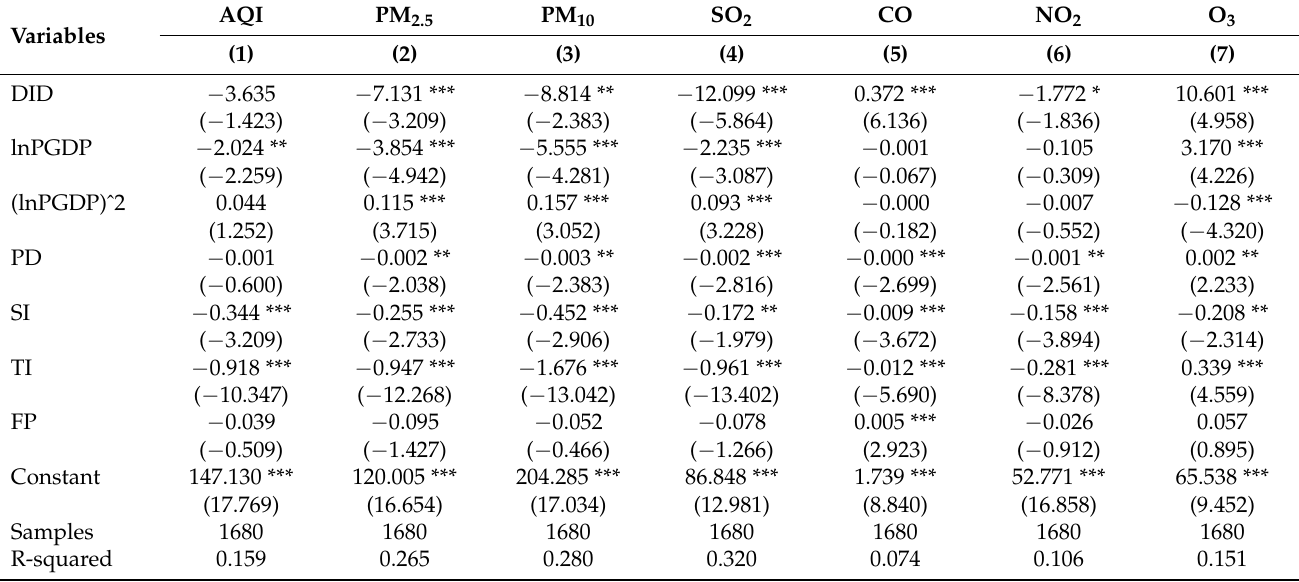
Table 2. The baseline results based on the DID